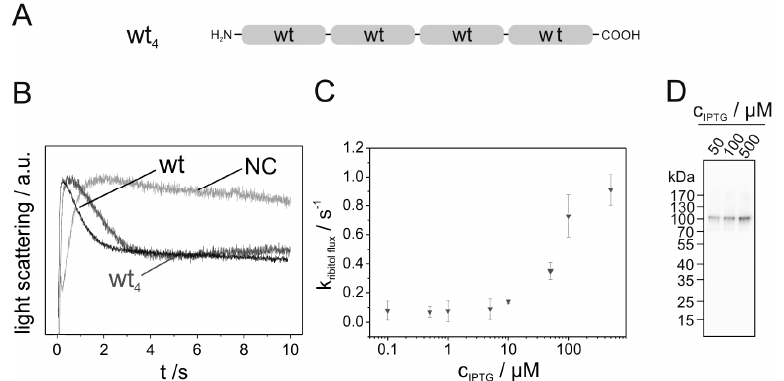
Figure 2. Activity of genetically fused GlpF homooligomer. ( A ) Schematic representation of the fused GlpF wild ‐ type (WT) homooligomer analyzed. Each light gray box represents one WT GlpF. ( B ) Typical light ‐ scattering curves of the WT 4 GlpF homooligomer (dark gray) and the (non ‐ fused) GlpF WT (black), determined after induction of protein expression with 500 μ M IPTG. GlpF ‐ free control cells (NC) (gray) were transformed with the plasmid pMalp2 and treated exactly as the protein expressing cells. The light ‐ scattering curves are the average of five measurements. ( C ) The rate constants of the ribitol conductance, facilitated by the fused GlpF WT homotetramer (WT 4 ) ( ), were determined by approximation of the light ‐ scattering curves using a single exponential decay function ( n = 3 ± SD) (see also Figure S1). ( D ) Western blot analysis, determining the expression level of the studied GlpF homooligomer at increasing isopropyl β‐ D ‐ 1 ‐ thiogalactopyranoside (IPTG) concentrations. For the Western blot analysis, an antibody recognizing the GlpF C ‐ terminus was used.